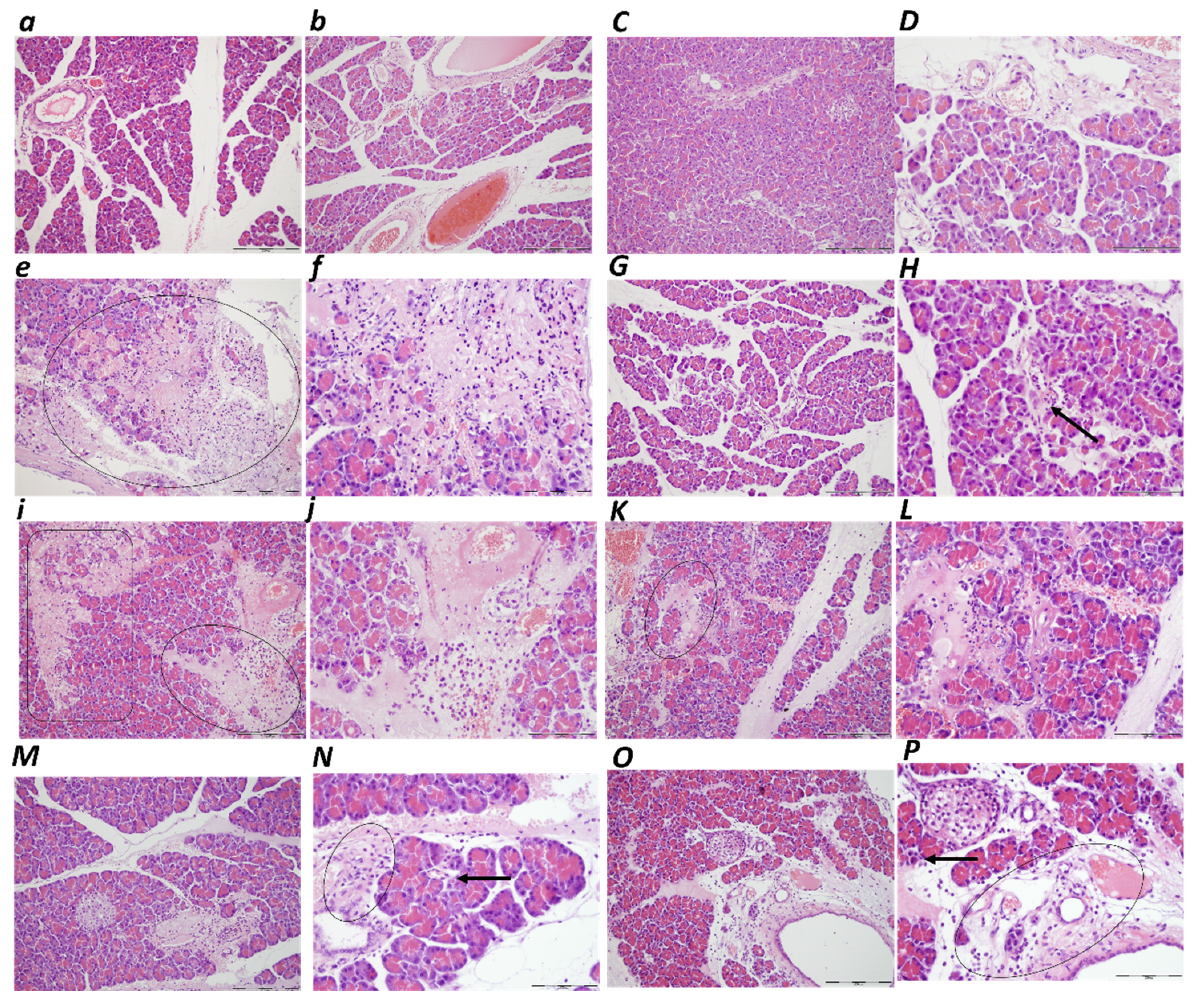
Figure 6. Pancreas lesion illustrative microscopic presentation in rats with obstructed bile duct ( a – P ) at the end of the ligation time periods of 30 min, 5 h, and 24 h; as an early regimen at 0–30 min ( a – D ), 0–5 h ( e – H ), and 0–24 h ( i – L ) application sacrifice period; and as a delayed regimen at 4.30 h–5 h ( M , N ) and 5 h–24 h ( O , P ) application sacrifice period in controls ( a , b , e , f , i , j ) and BPC 157- treated rats ( C , D , G , H , K , L – P ). ( a , b ) (Control, 0–30 min) Diffuse edema of interlobar septe, interlobular septe, interacinal spaces and focal expansion of intercellular spaces. Perivascular infiltration 6–10 leukocytes/HPF. ( C , D ) (BPC 157, 0–30 min) Focal edema of interlobar septe. No acinar necrosis, hemorrage, fat necrosis, inflammation or perivascular infiltrate. ( e , f ) (Control, 0–5 h) Diffuse edema of interlobar septe and interacinal spaces, and focal expansion of intercellular spaces, a diffuse occurrence of 5–10 necrotic acinar cells, a focal occurrence of 11–16 necrotic cells/HPF (black arrow), up to 2 foci of hemorrhage, up to 4 foci of fat necrosis (marked area), and perivascular infiltration 16–20 leukocytes/HPF. ( G , H ) (BPC 157, 0–5 h) Focal edema of interlobar septae. Focal occurence of 1–4 necrotic acinar cells/HPF (black arrow). No hemorrage and fat necrosis. Perivascular infiltration 2–5 leukocytes/HPF. ( i , j ) (Control, 0–24 h) Diffuse edema of interlobar septe, interlobular septe, interacinal spaces and focal expansion of intercellular spaces. More than 16 necrotic acinar cells/HPF (extensive confluent necrosis) (marked area). More than 8 foci of hemorrhage. Up to 7 foci of hemorrage and fat necrosis (marked area). Perivascular infiltration >30 leukocytes/HPF. ( K , L ) (BPC 157, 0–24 h) Focal edema of interlobar septe. Diffuse occurence of 1–4 necrotic acinar cells and focal occurrence of 15–10 necrotic cells/HPF. One focus of hemorrhage or fat necrosis (marked area). Perivascular infiltration 6–10 leukocytes/HPF. BPC 157 delayed regimens ( M – P ). ( M , N ) (BPC 157, 4.30 h–5 h) Focal edema of interlobar septe. Diffuse occurrence 5–10 necrotic cells/HPF (black arrow) and focal occurrence 11–16 necrotic cells/HPF. Up to one focus of hemorrhage, and up to 7 foci of fat necrosis, mostly in the pancreatic tail, while